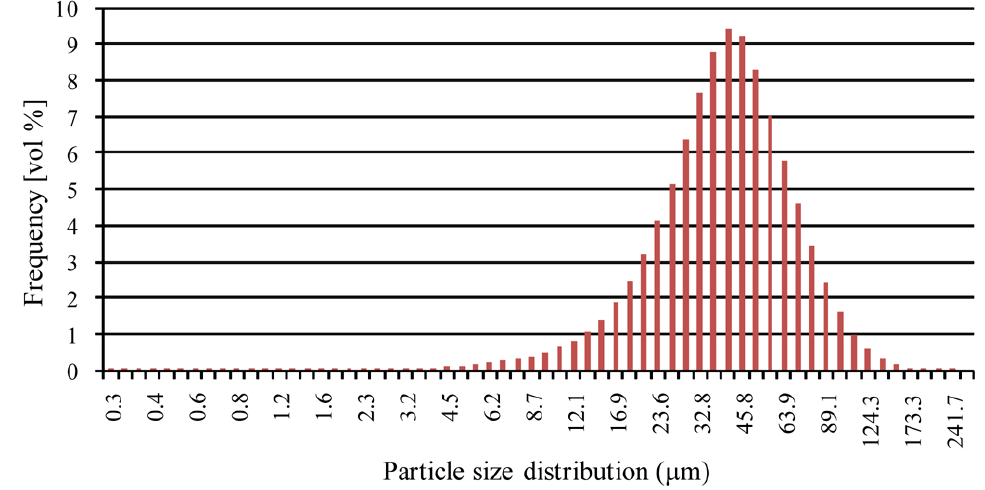
Figure 4. Particle size distribution of as-received aluminum alloy